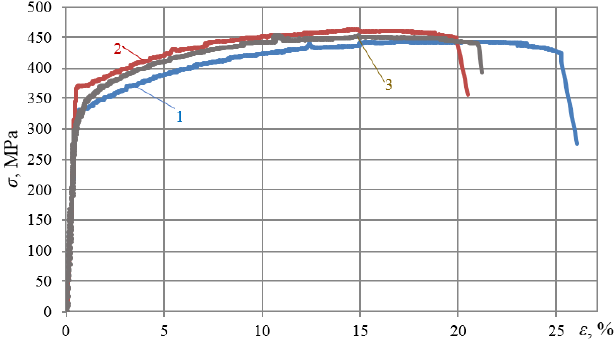
Figure 2. Stress – strain curves of aluminum alloys at room temperature: 1 — D16ChATW; 2 — 2024- Figure 2. Stress–strain curves of aluminum alloys at room temperature: 1—D16ChATW; 2—2024- T351; 3 — T alloy. T351; 3—T